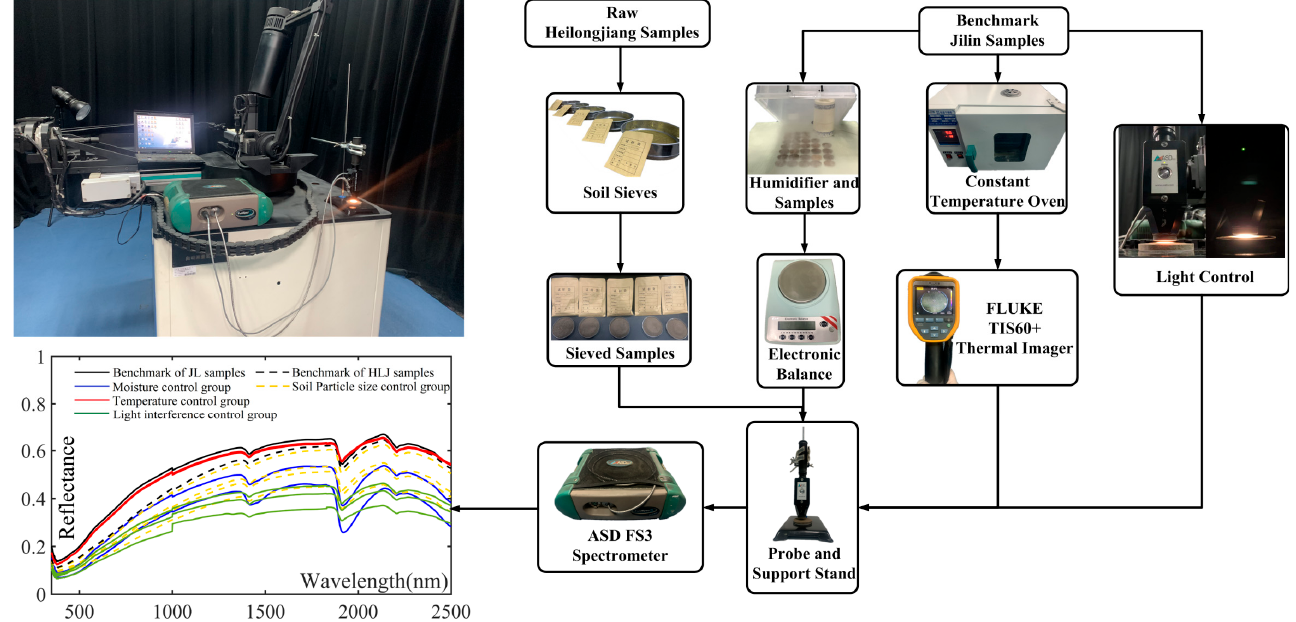
Figure 2. The standard spectral laboratory in JLU: darkroom environment ( top left ), device interac- tion flow chart ( right ), and the average spectral reflectance of each control group ( bottom left ).